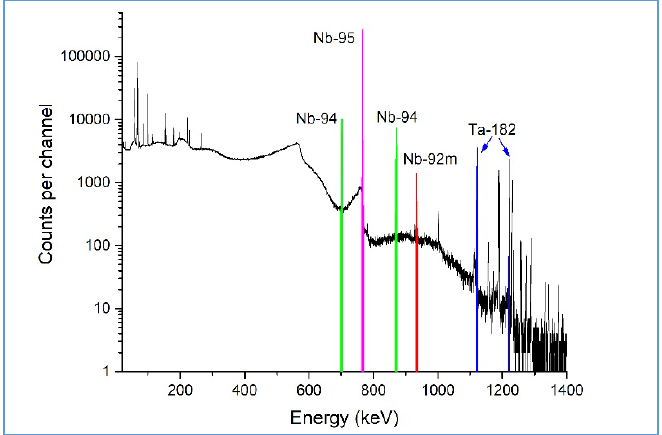
Fig. 2. Gamma spectrum in the 15 keV-1500 keV region allowing the quantification of impurities